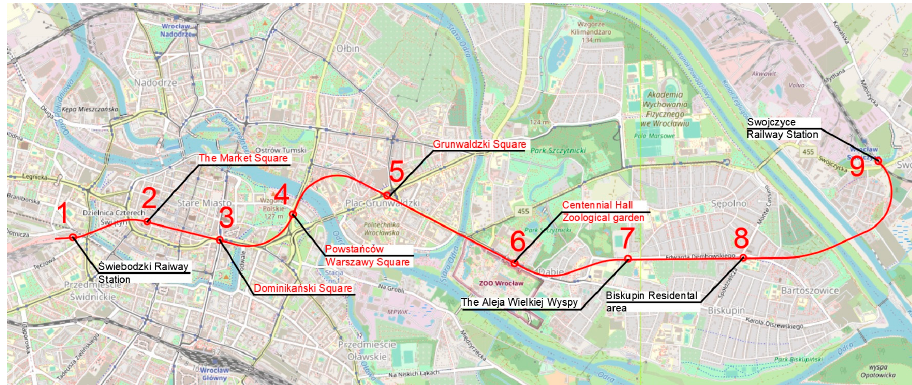
Figure 5. Route one (background: openstreetmap.org).